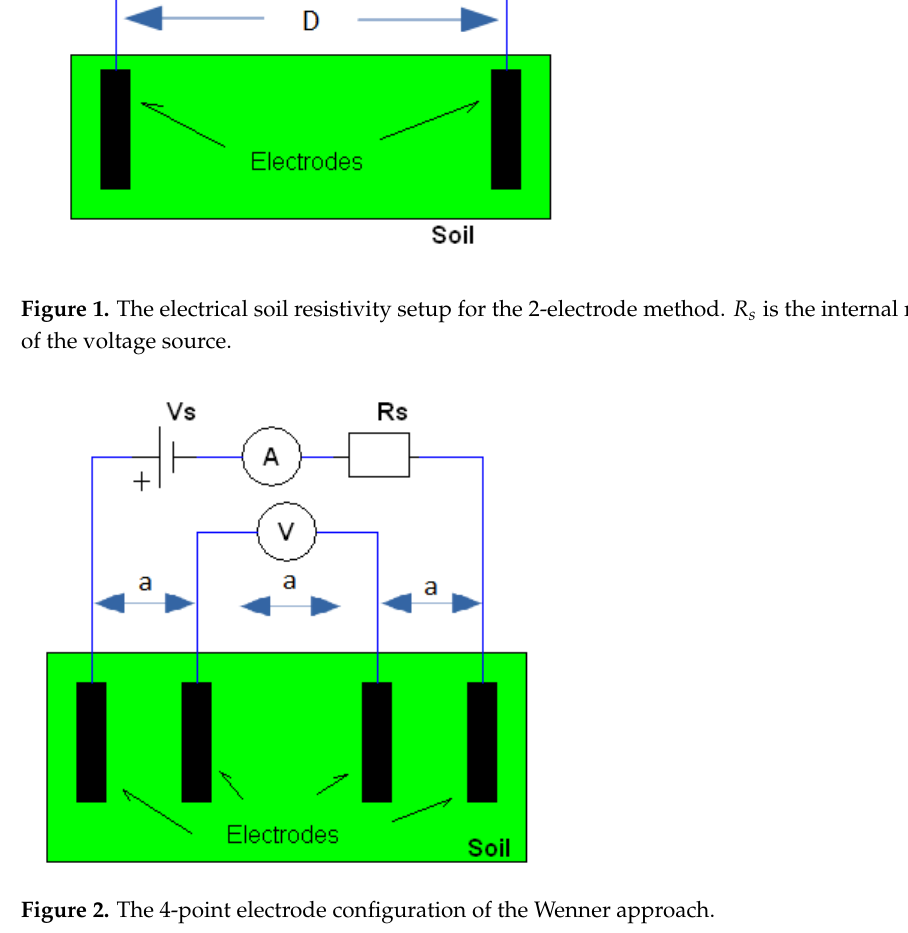
Figure 2. The 4-point electrode configuration of the Wenner